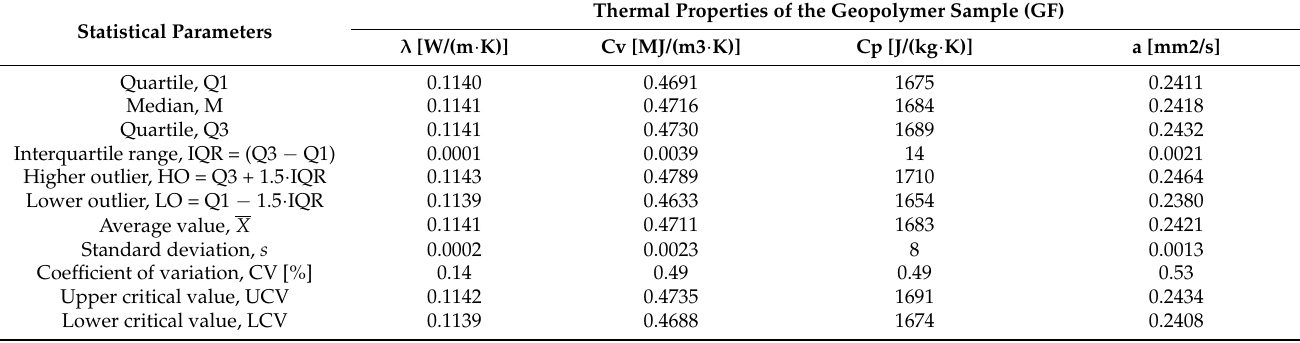
Table 3. The obtained values of the thermal parameters of the geopolymer sample and modified gypsum; additionally, calculated statistical